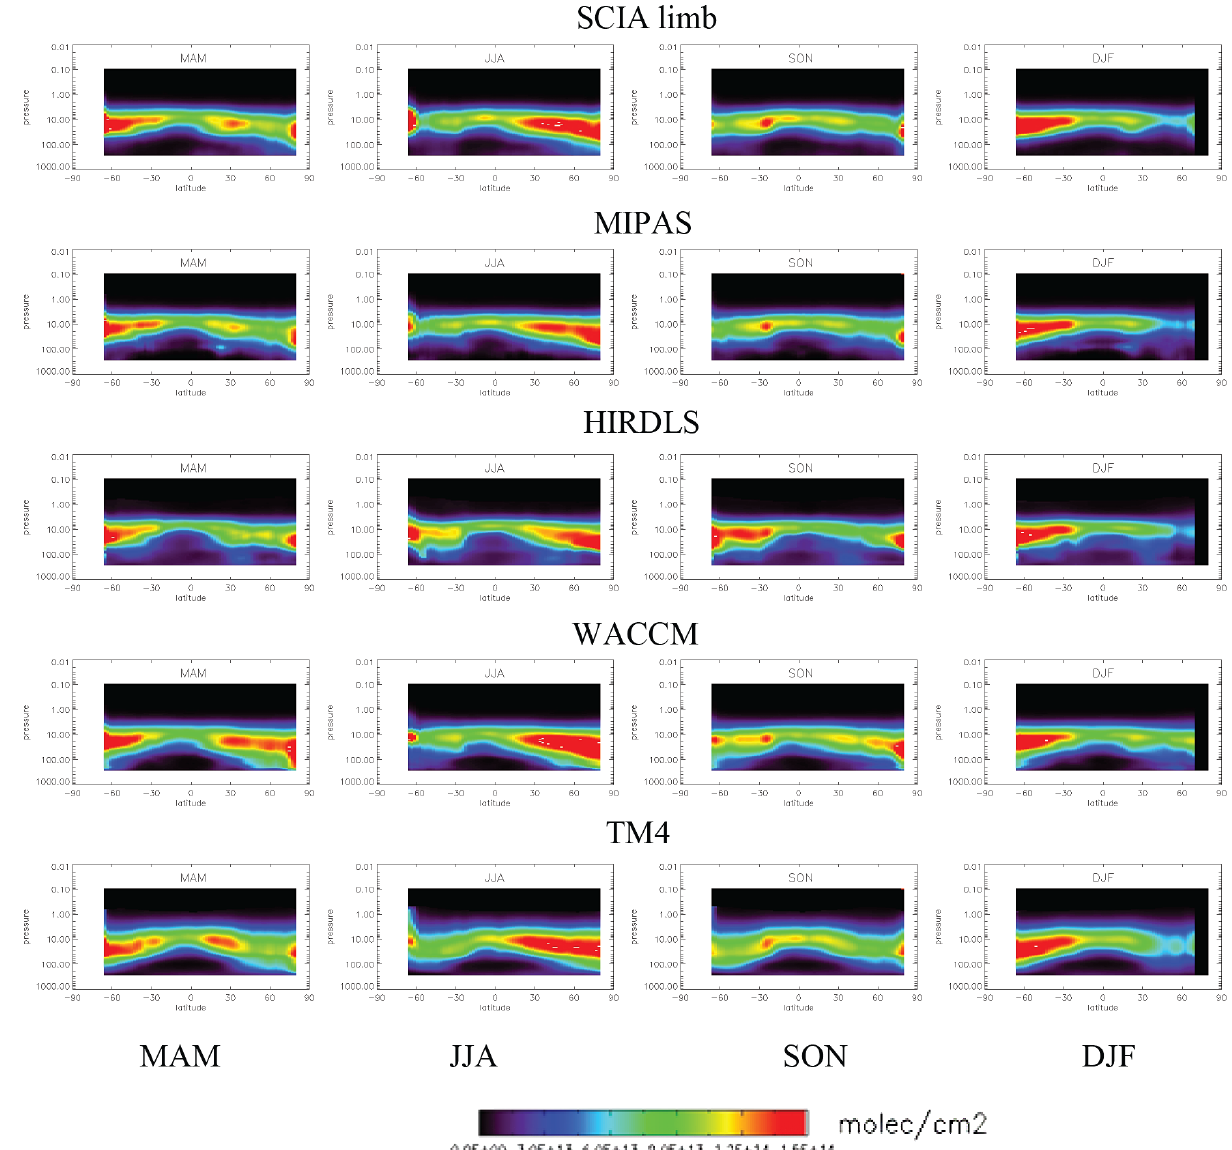
Figure 6. Seasonal mean stratospheric NO 2 partial column profiles for SCIAMACHY limb (first row), MIPAS (second row), HIRDLS (third row), WACCM (fourth row) and TM4 (fifth row) as a function of